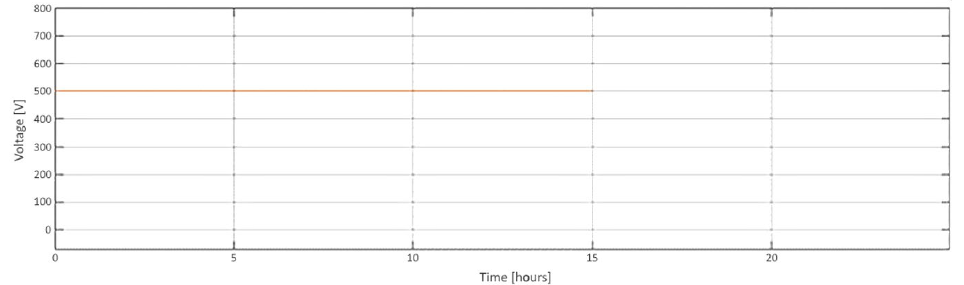
Figure 28. VSC inverter voltage graph.